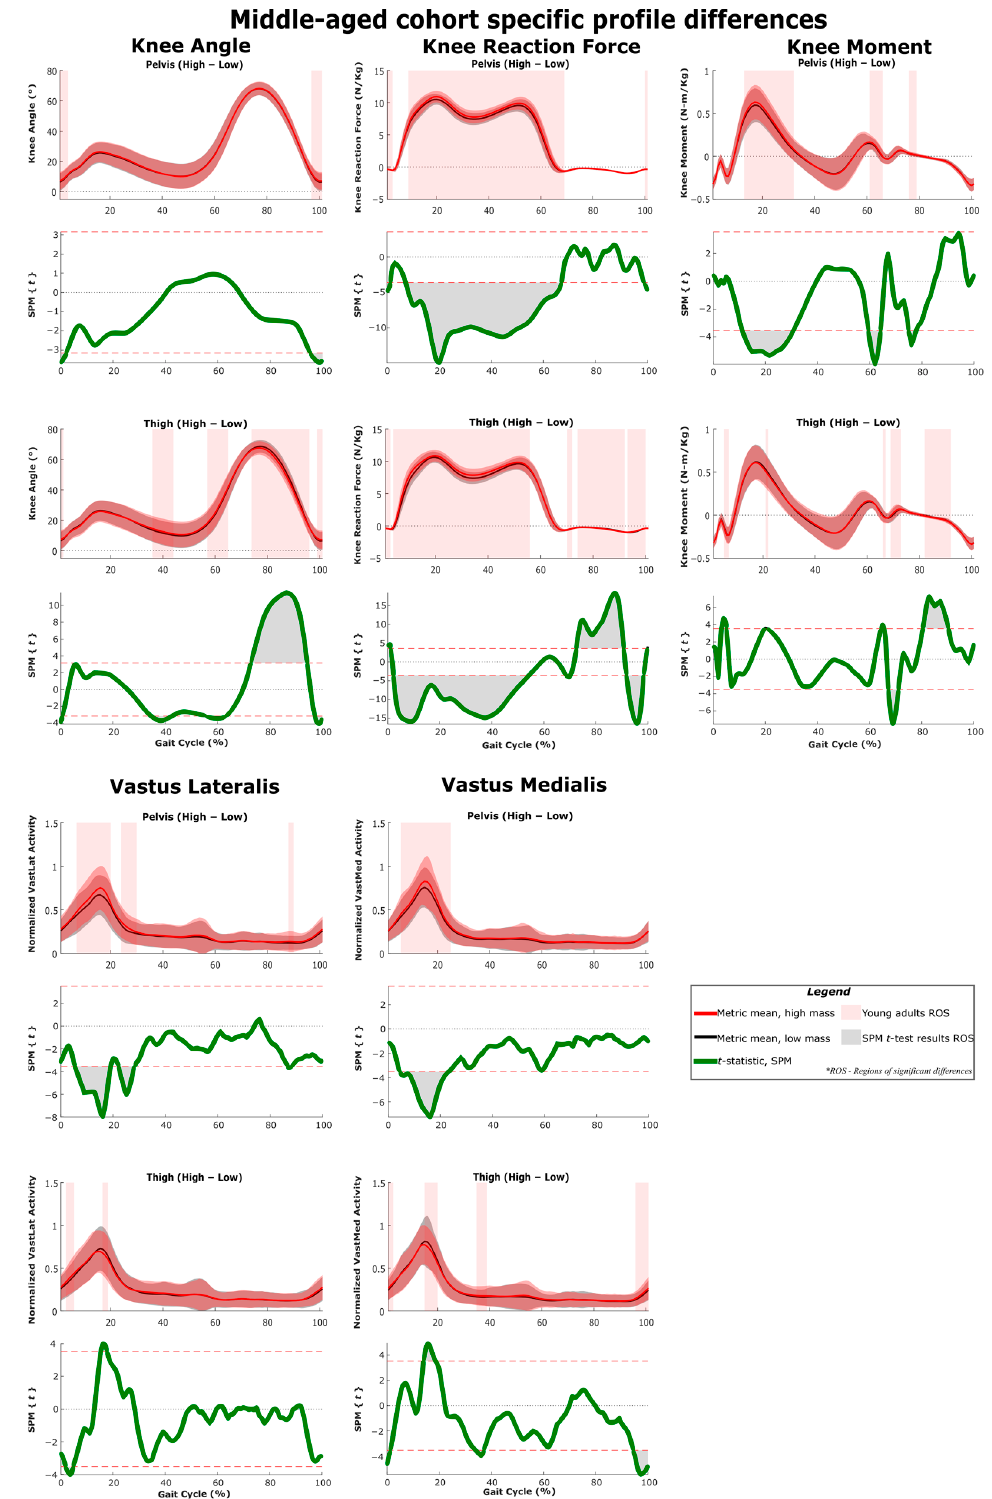
Figure 8. SPM t -test results and profile plots of the metrics, comparing low mass to high mass in the pelvis and thigh segments for participants in the middle-aged cohort. Joint parameters are primarily related to the knee joint. The t -statistic is qualitatively identical to the effect size and can be used as an indicator of practical significance.